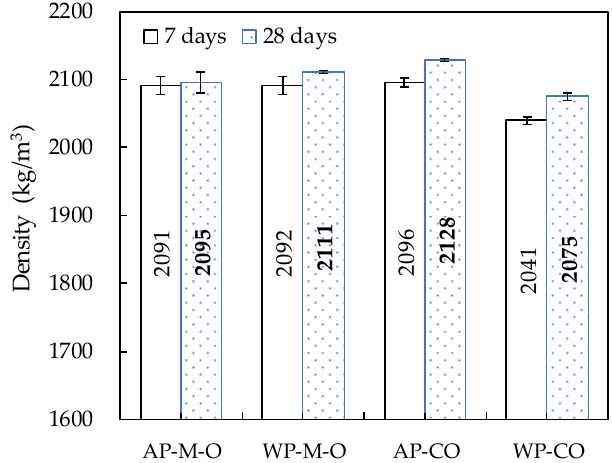
Figure 14. Density of cylindrical specimens.